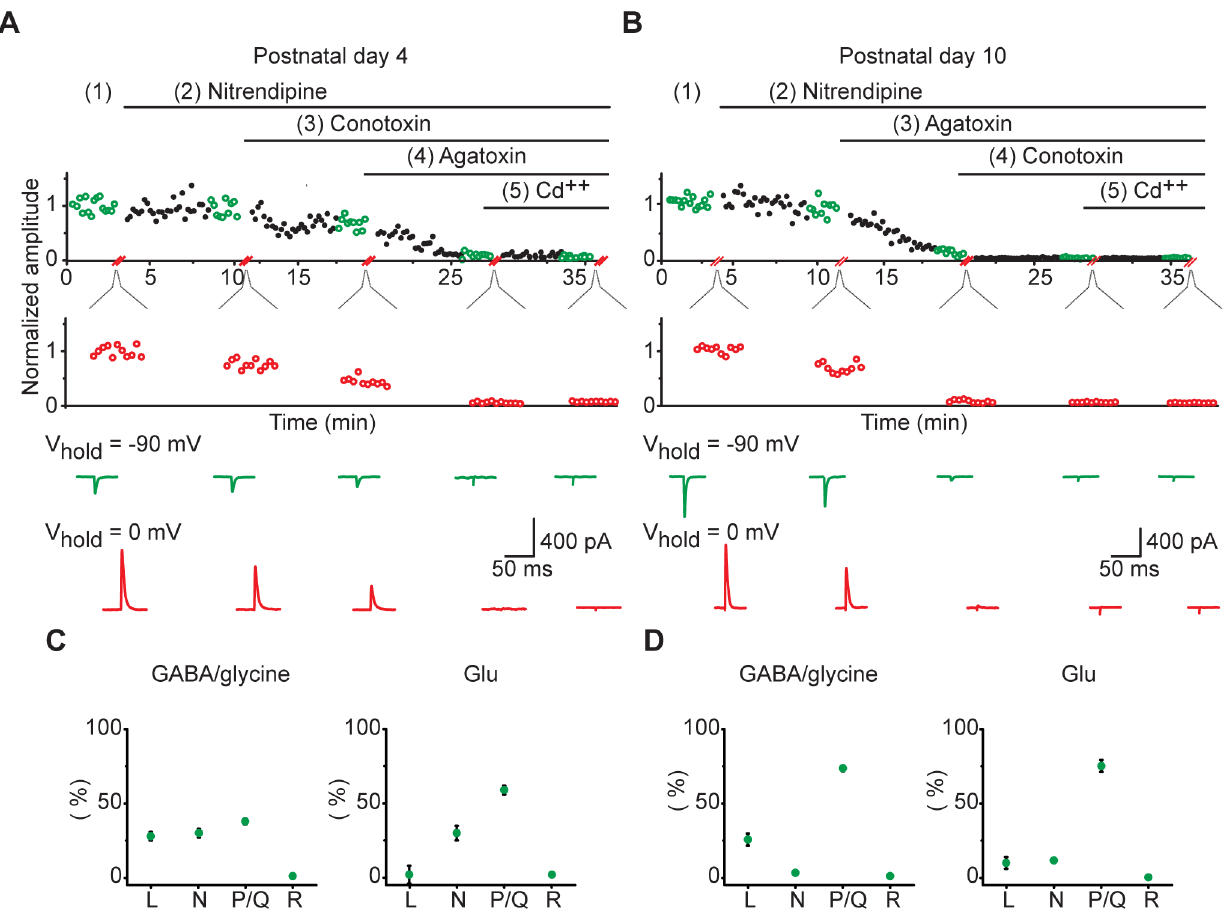
Figure 3. Proportional contribution of VGCC subtypes to GABA/glycine and glutamate transmission. ( A–B ) Representative examples showing how VGCC contribution to GABA/gly and glutamate neurotransmission was determined in ( A ) a P4 slice, and ( B ) a P10 slice. Average GABA/ gly (red) and glutamate (green) current traces are shown below, and correspond to the colored points above for each component. ( C–D ) Proportional contribution of each VGCC to GABA/gly and glutamate components for the P4 slice shown in A ( C ), and for the P10 slice shown in B ( D ).